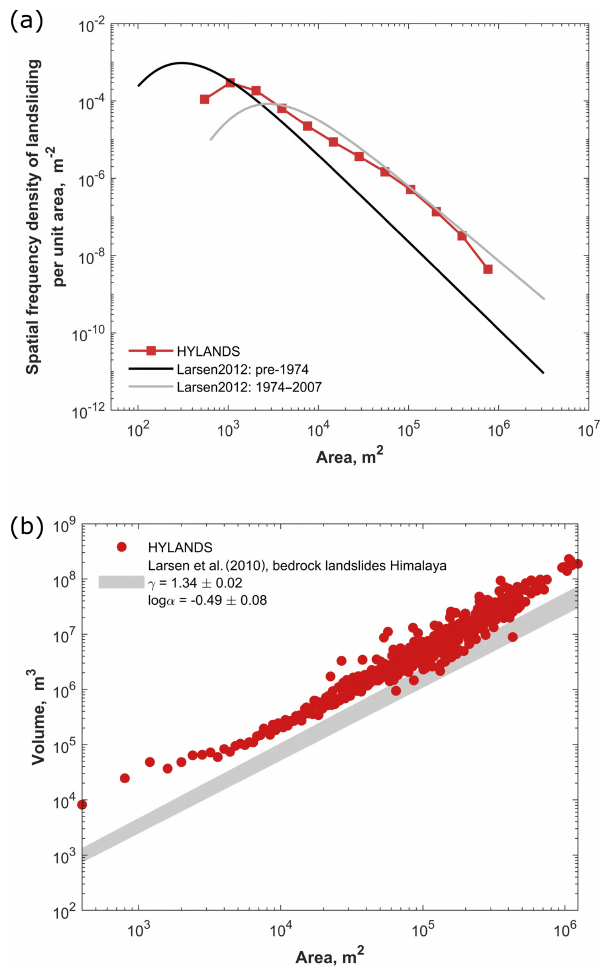
Figure 8. Comparison between modeled and observed character- istic landslide scaling relationships. (a) Magnitude–frequency rela- tionship. The grey and black lines represent the best-fitting inverse gamma distribution (Eq. 19) of the landslide activity mapped before 1974 and between 1974 and 2012, respectively (Larsen and Mont- gomery, 2012). The fitting parameters are, respectively, ( a l = 768 × 10 − 6 , s l = − 32 . 6 × 10 − 6 , ρ l = 1 . 27) and ( a l = 6100 × 10 − 6 , s l = − 311 × 10 − 6 , ρ l = 0 . 96). The red dots represent the magnitude– frequency distribution simulated using HyLands. (b) Area–volume relationship. The grey dashed zone represents the expected area– volume scaling relationship, observed for bedrock landslides in the Himalaya (Larsen et al., 2010). Fit is calculated using Eq. (20) with fitting parameters γ = 1 . 32 ± 0 . 02 and 10 log α = − 0 . 49 ± 0 . 06. The red dots represent the geometry of the landslides simulated with Hy-